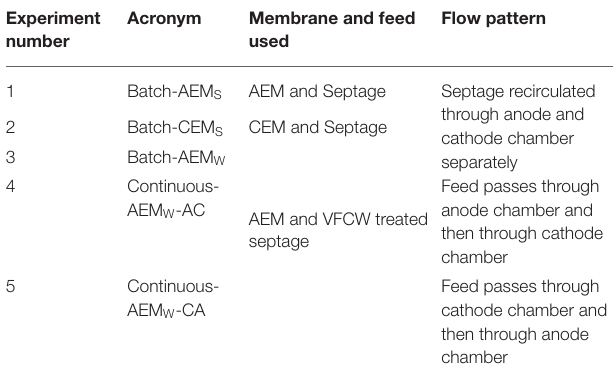
TABLE 1 | List of electrolysis experiments conducted in the divided